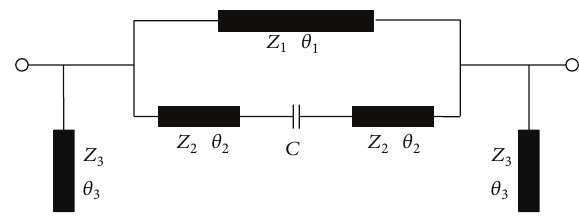
Figure 1: The proposed LPF